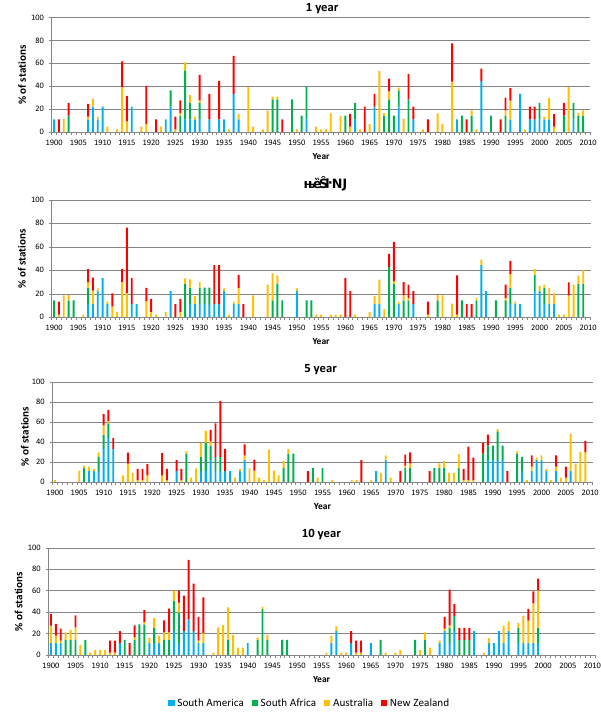
Figure 3. Total percentage of stations for each region where the 1– 10year cumulative rainfall was among the five lowest during the period